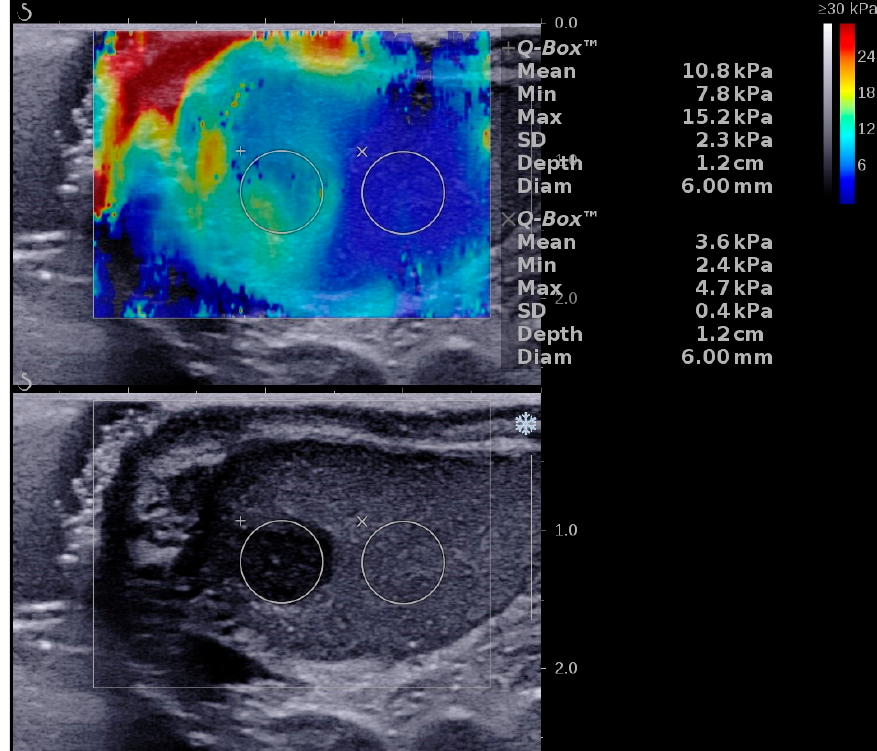
Figure 4. Illustration of a two-dimensional shear wave elastography (2D SWE) performed in a patient with a segmental testicular infarction using the SuperSonic Imagine Aixplorer Ultrasound device. A color scale map is displayed in the upper part of the image, low stiffness is color-coded with blue, while red signifies high stiffness. Numeric 2D SWE results (expressed in kPa) are displayed on the right side of the image. The Q-Box displays the mean, median, minimum, maximum and standard deviation (SD) of the measurements, along with the depth, the diameter of the region of interest (ROI) and the stability index (SI).